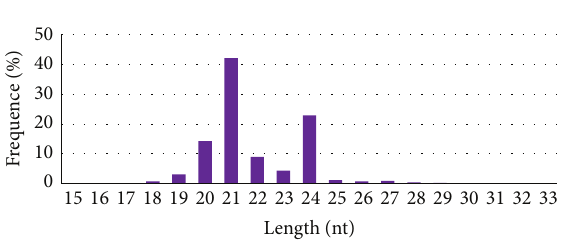
Figure 1: Length distribution of small RNAs found in jute (violet bar indicates the percentage of total